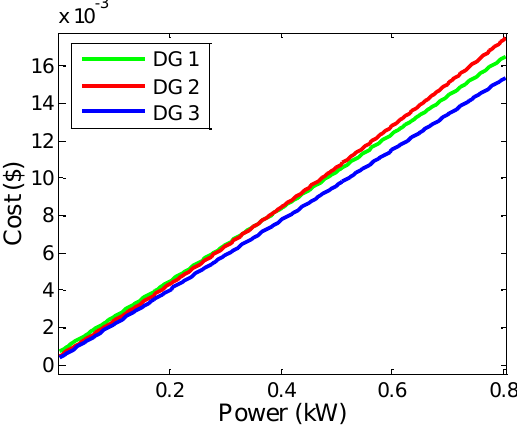
Figure 6. Curve of cost function for three DG units. Table 1. Coefficients of the Operation Cost Function.